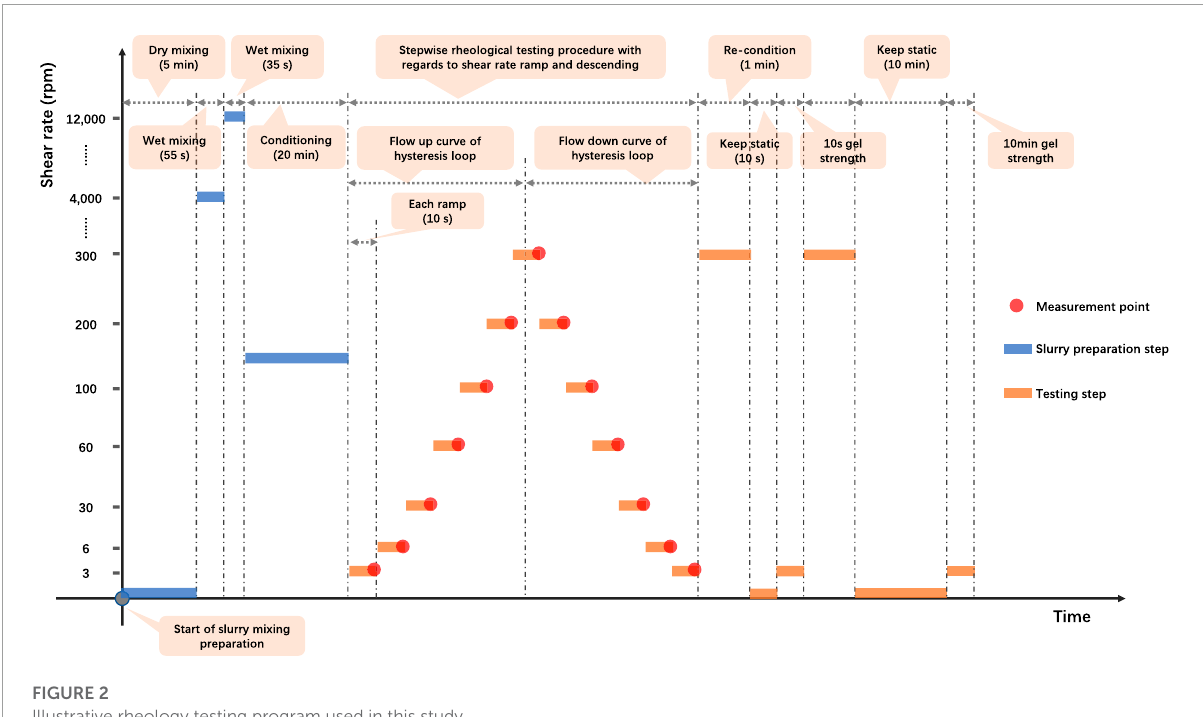
FIGURE 2 Illustrative rheology testing program used in this